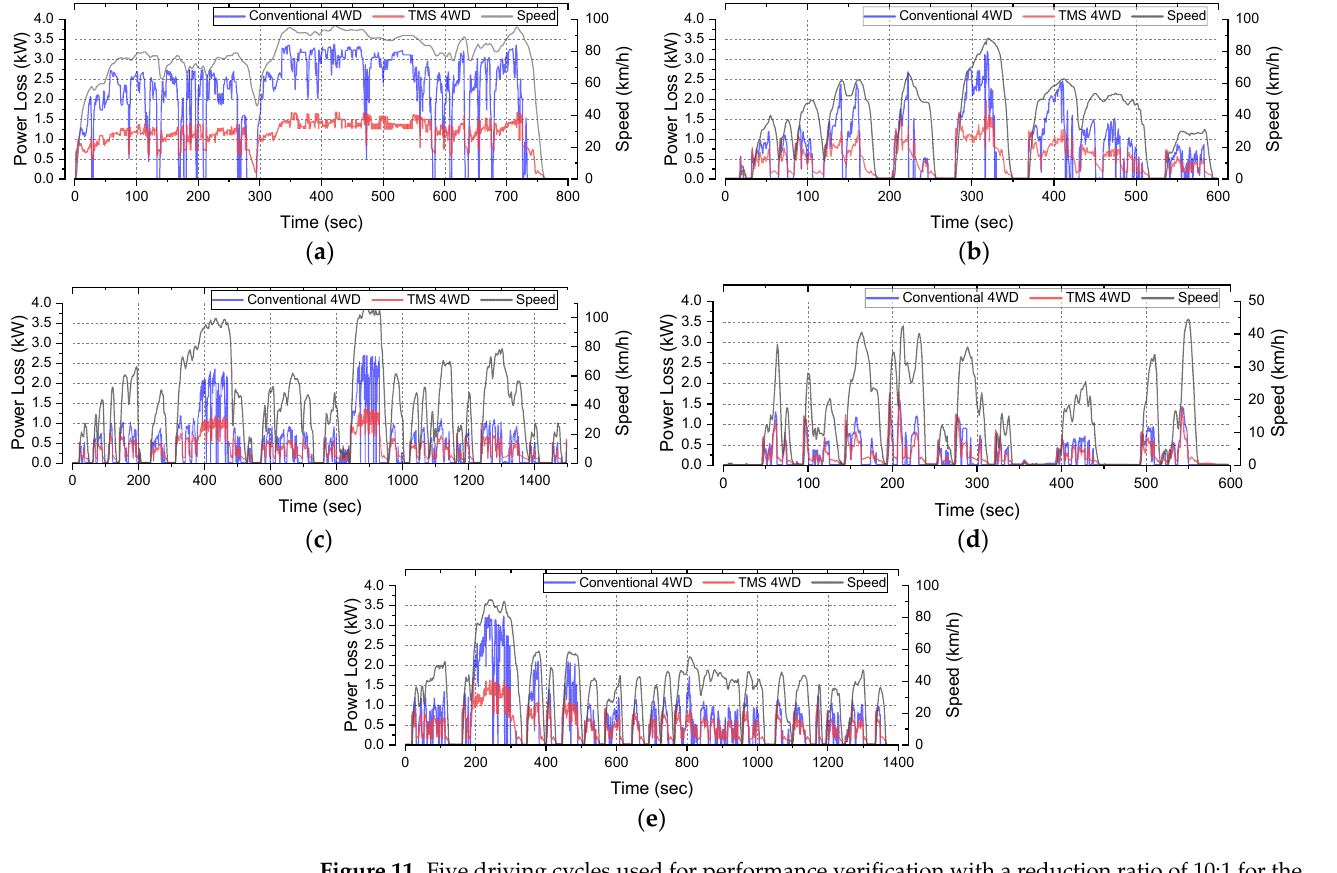
Figure 11. Five driving cycles used for performance verification with a reduction ratio of 10:1 for the front and rear wheels: ( a ) HWFET, ( b ) SC03, ( c ) LA92, ( d ) NYCC, ( e ) UDDS. Figure 12 shows the reduction in power loss and average reduction in power loss of the motor in the cycle performed in Figure 11. In the HWFET cycle, the loss of 1.145 kW compared to the previous 2.168 kW showed a 47.18% reduction, which is an average of 1.023 kW. The SC03 cycle showed a reduction of power loss of 27.91%, which is an average of 0.064 kW with a loss of 0.165 kW compared to the previous one of 0.229 kW. The LA92 cycle showed a reduction in power loss of 25.97%, an average of 0.268 kW, with a loss of 0.320 kW compared to the previous loss of 0.433 kW. In the NYCC cycle, the loss of 0.074 kW compared to the previous loss of 0.081 kW showed a reduction of 7.76%, an average of 0.007 kW. In the UDDS cycle, the loss of 0.333 kW compared to the previous loss of 0.446 kW showed a reduction of 25.20%, i.e., an average of 0.113 kW.